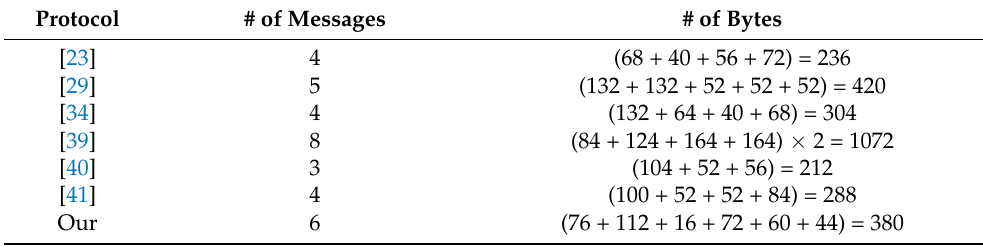
Table 7. Communication cost